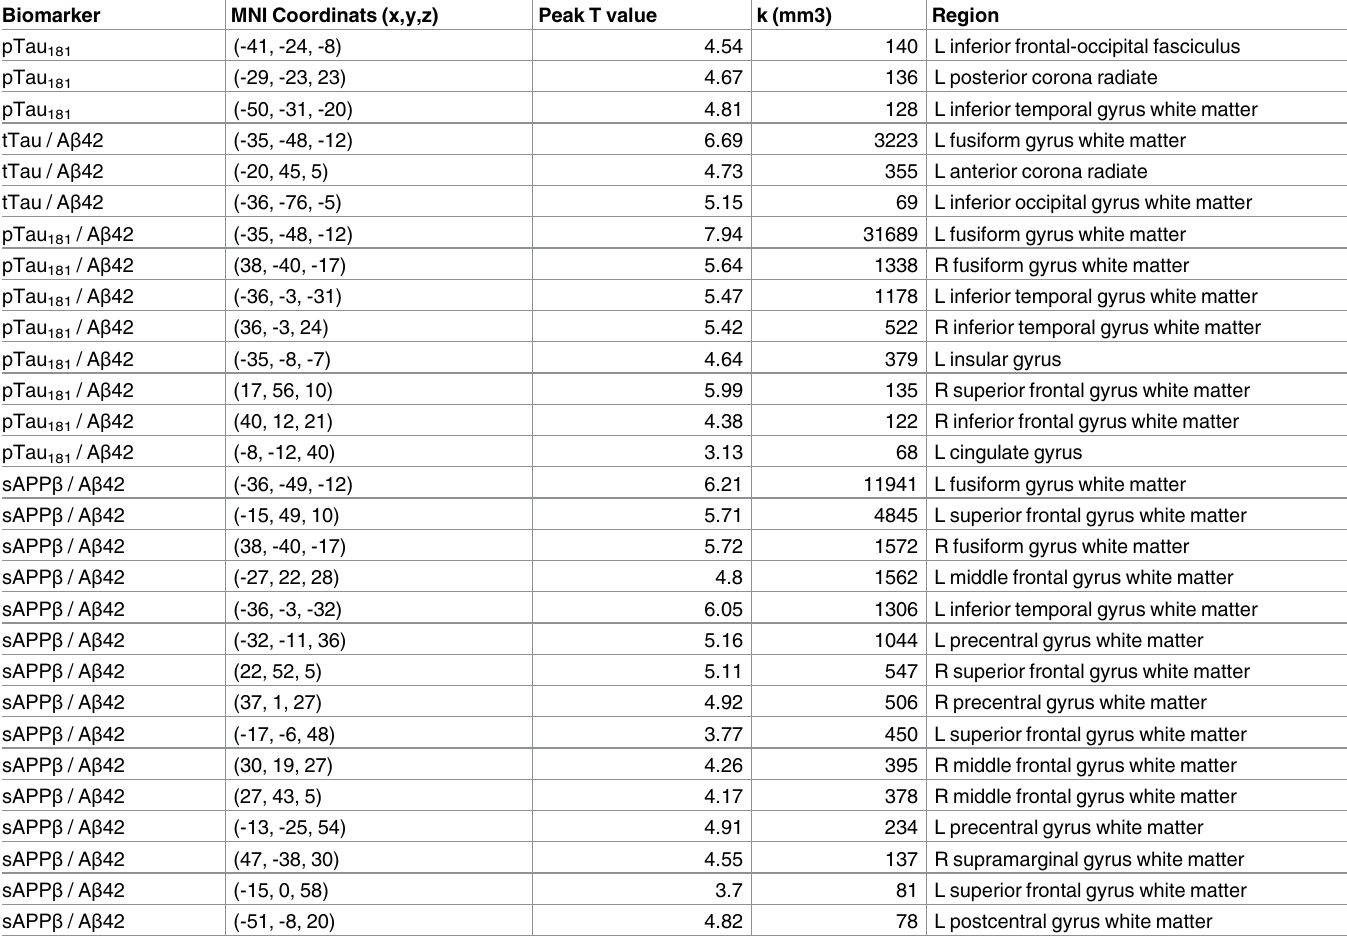
Table 6. Listing of all significant clusters for which the FWE-DTI f-value was correlated to one of the predictors.